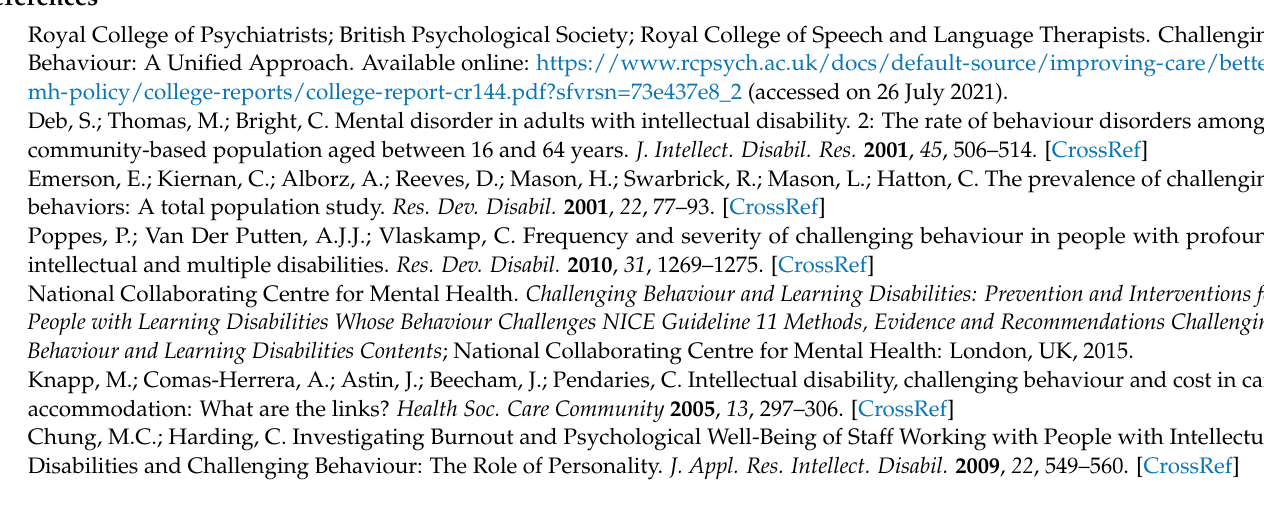
Figure A1. Comprehensive Assessment of Triggers for behaviours of concern Scale (CATS).